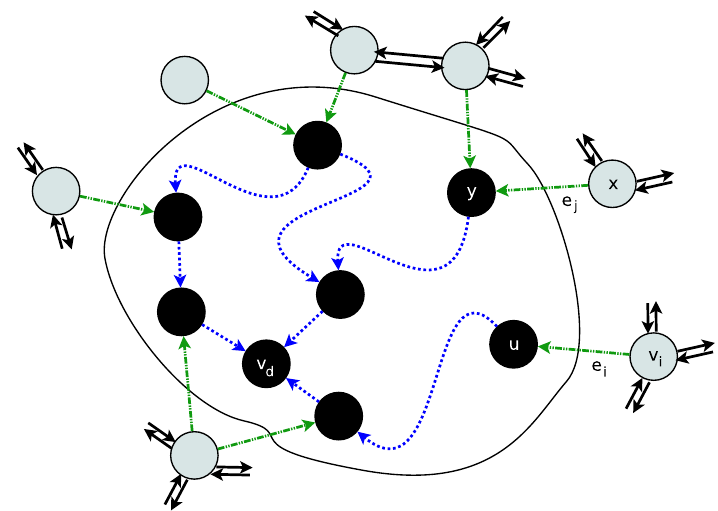
Figure 5: A visual snapshot of Algorithm